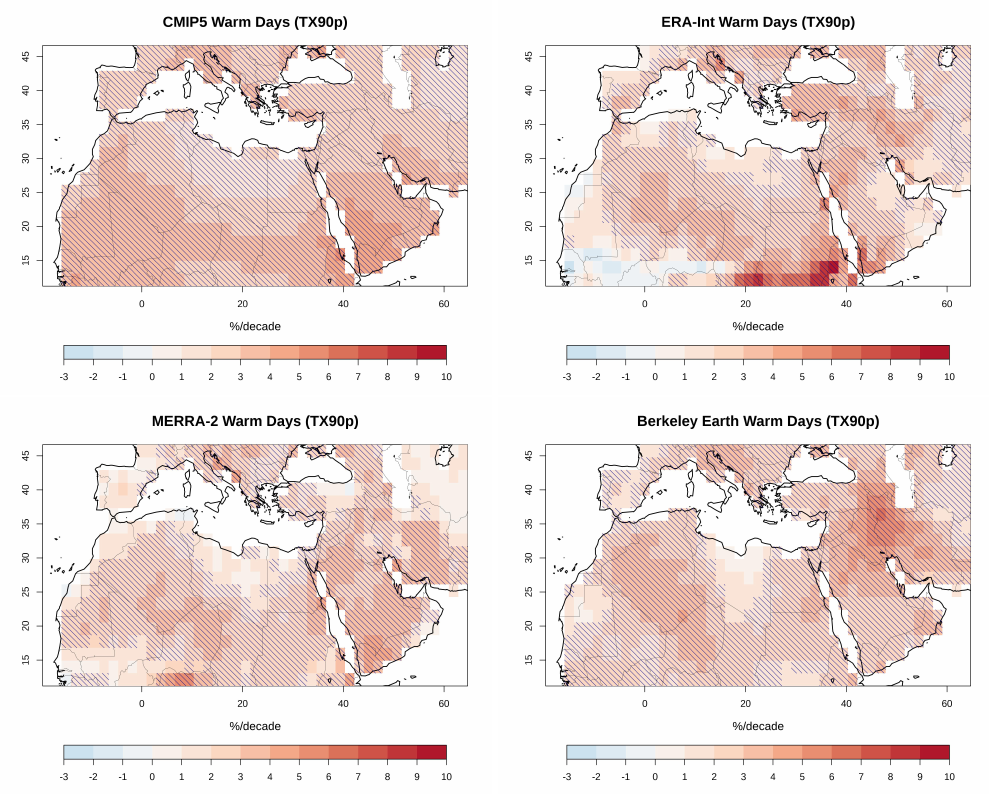
Figure 8. 1980–2018 decadal trend of the exceedance rate of Warm Days (TX90p) for the: CMIP5 multi-model ensemble mean ( top left ), ERA-Interim ( top right ), MERRA-2 ( bottom left ), and Berkeley Earth ( bottom right